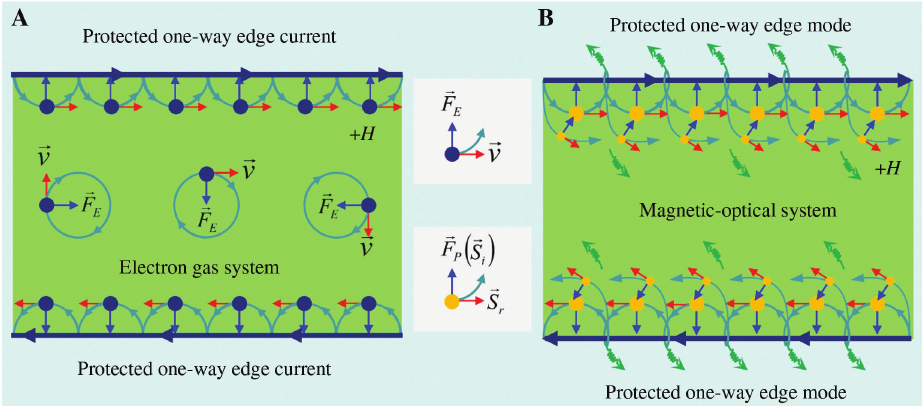
(cid:31) (cid:31) v represents electron velocity and F E